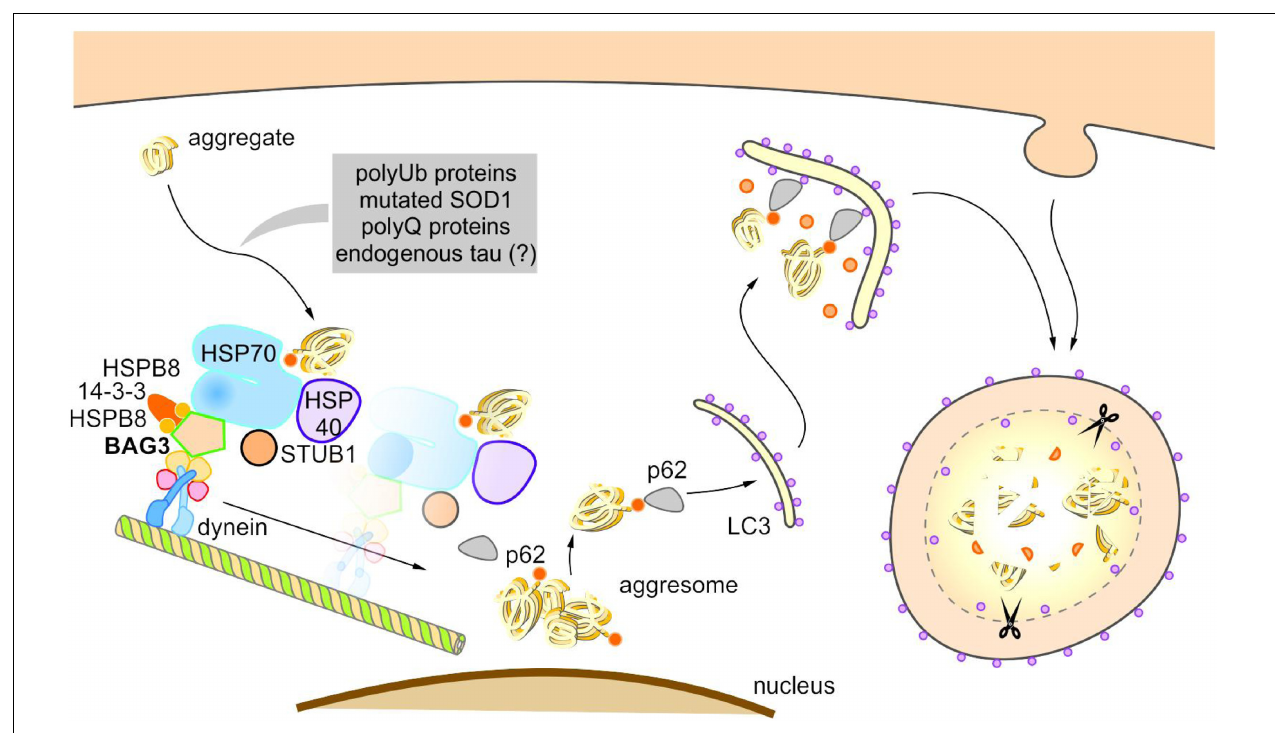
FIGURE 5 | Model of BAG3-mediated aggresome-targeting and selective macroautophagy. During aging and under acute cellular stress, misfolded proteins and/or aggregates bind to a multi-chaperone complex consisting of HSPB8, HSP70, HSP40, BAG3, 14-3-3 γ , and STUB1. Subsequently, BAG3 mediates in concert with the 14-3-3 γ protein the association of this complex with the dynein complex and thereby initiates the microtubule-based retrograde transport of the degradation-prone substrates to the aggresome. BAG3 induces the selective macroautophagy of the substrates by complexing with the macroautophagy receptor protein p62 that interacts simultaneously with both the substrate as well as the autophagosome membrane-associated protein LC3. The substrates are finally degraded by the autophagic-lysosomal